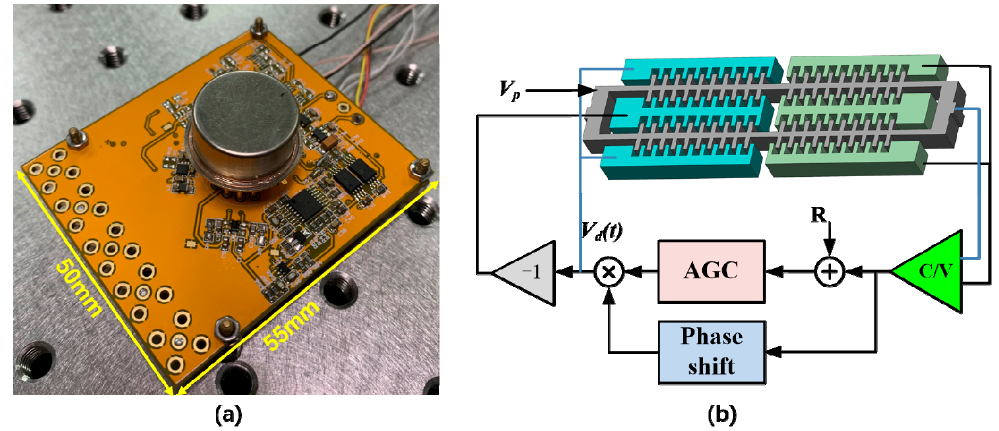
Figure 9. The test circuit for vacuum sealed SRA. ( a ) Test PCB mounted with the SRA; ( b ) Control scheme of self-oscillation loop.